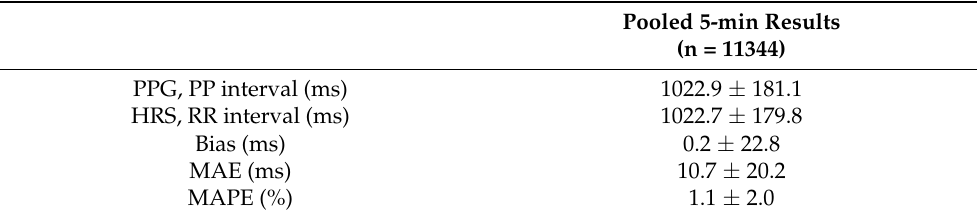
PPG, photoplethysmography; HRS, heart rate sensor; MAE, mean absolute error, MAPE, mean absolute percentage